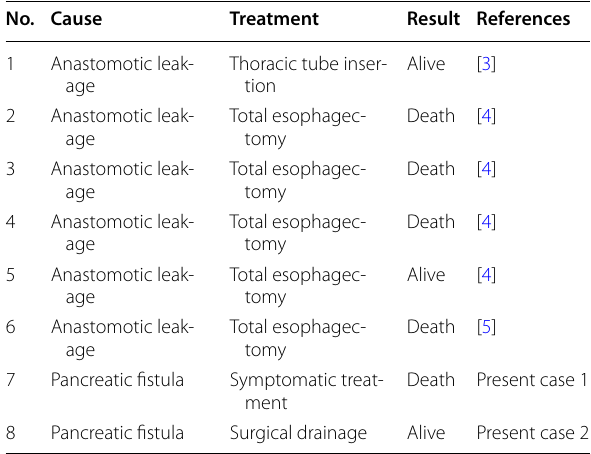
Table 1 Documented cases of mediastinitis caused by total